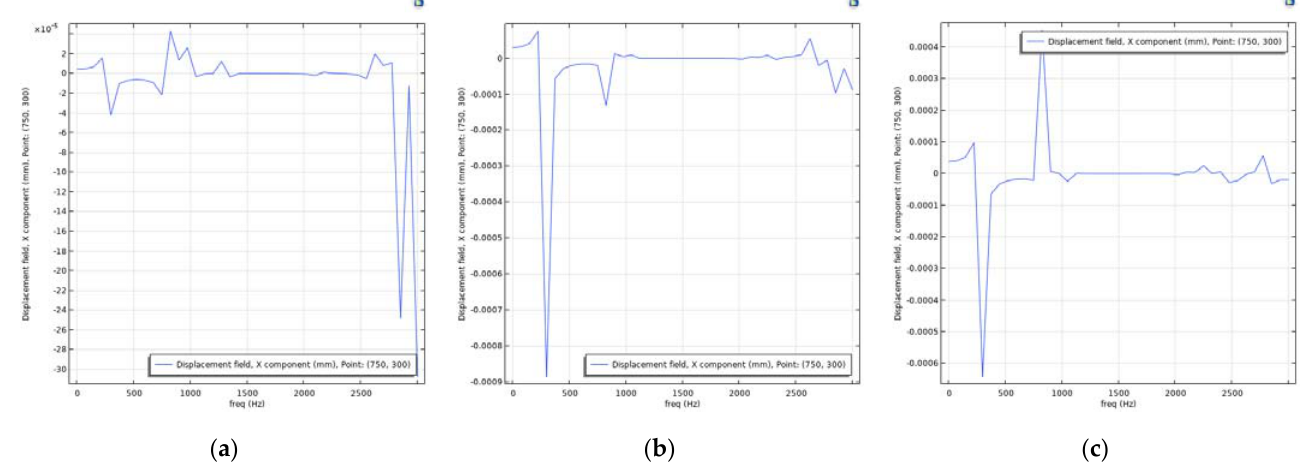
Figure 19. Displacement-frequency diagram of ( a ) 170 × 80 ellipse combination grid with 6 mm bar and 170 × 40 ellipse, with 40 mm diameter circular inclusion and 15 mm bar thickness, ( b ) 170 × 80 ellipse combination grid with 12 mm bar and 170 × 40 ellipse, with 40 mm diameter circular inclusion and 15 mm bar thickness and ( c ) 170 × 80 ellipse combination grid with 12 mm bar and 170 × 40 ellipse, with 40 mm diameter circular inclusion and 12 mm bar thickness.